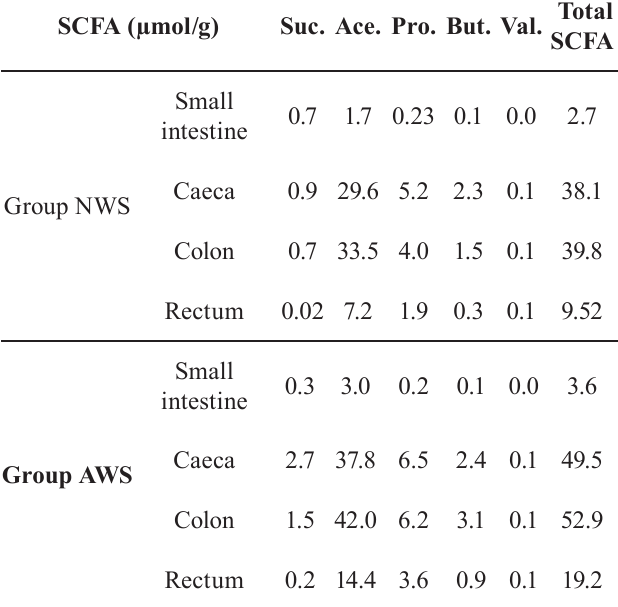
TABLE II - SCFA content in the gut sections of experimental mice